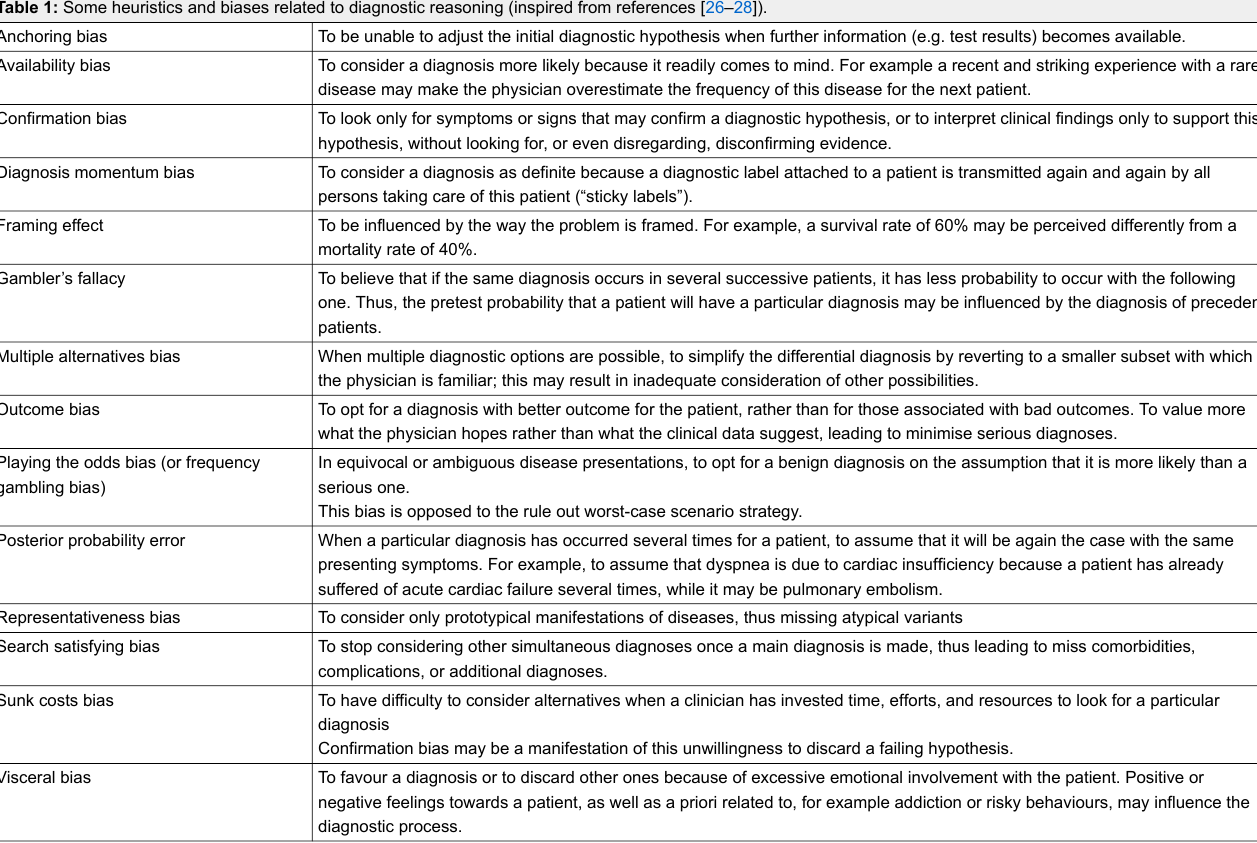
Table 1: Some heuristics and biases related to diagnostic reasoning (inspired from references [26–28]). Anchoring